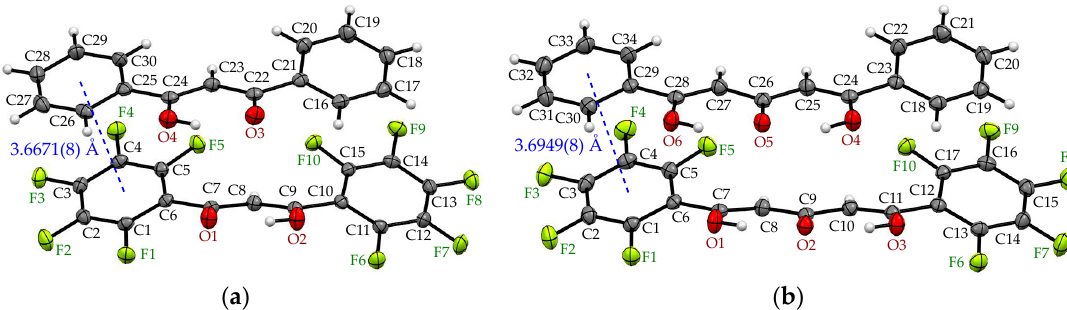
Figure 3. ORTEP drawings of the crystal structure of ( a ) H 1 • H 3 and ( b ) H 2 2 • H 2 4 with 50% probability thermal ellipsoids.